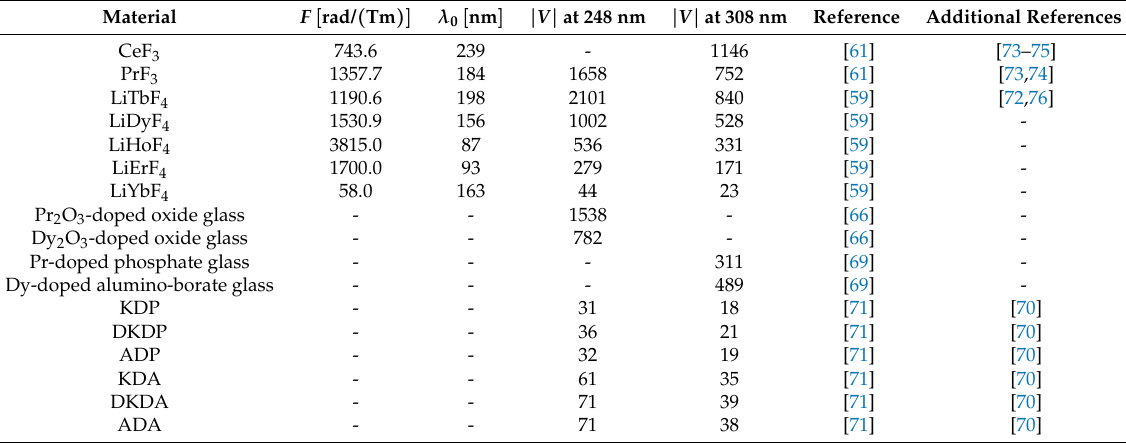
Table 1. A brief overview of magneto-active materials for the UV FDs ( λ < 400 nm). The Verdet constant dispersion V ( λ ) is given by the single-transition model in Equation (13) with the specified ( F , λ 0 )-parameters; the G -parameter is equal to 0 for all materials. The listed V -values are the absolute values of the Verdet constant, specified in rad/ ( Tm )